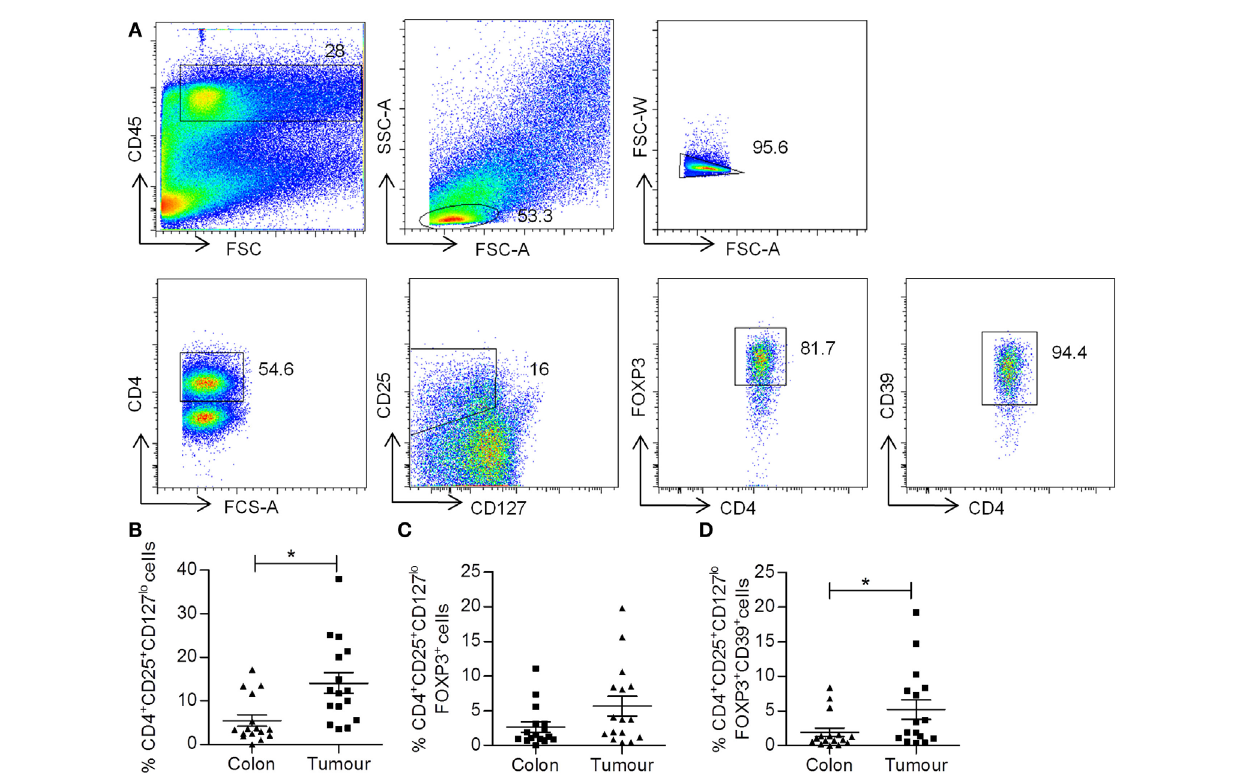
FigUre 5 | increased frequency of cD4 + cD25 + cD127 lo and cD4 + cD25 + cD127 lo FoxP3 + cD39 + Treg cells in colorectal tumor tissue . Tumor tissue and adjacent uninvolved colonic tissue were enzymatically digested to form a single cell suspension, which were stained with antibodies specific for CD45, CD4, CD25, CD127, FOXP3, and CD39, and were analyzed by flow cytometry to identify Treg cell populations. The sequential gating strategy used to identify Treg cell populations is shown in (a) . The graphs show the frequency of CD4 + CD25 + CD127 lo (B) , CD4 + CD25 + CD127 lo FOXP3 + (c) , and CD4 + CD25 + CD127 lo FOXP3 + CD39 + (D) Treg cells. * p < 0.05, as determined by the Wilcoxon signed rank